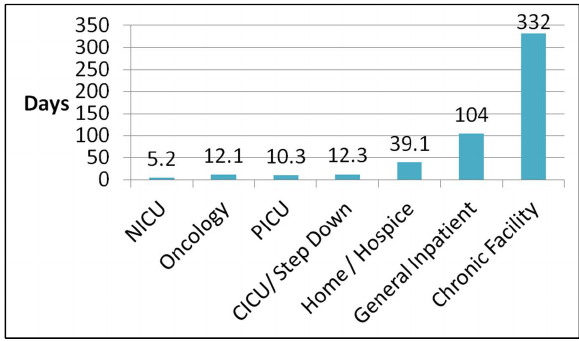
Figure 4. Interval in days between DNR order placement and death. No statistically